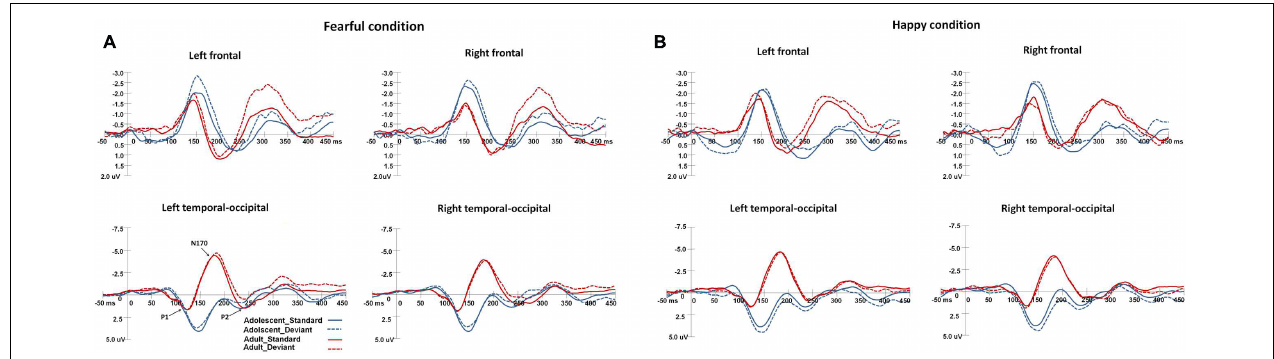
FIGURE 2 | The grand-average ERPs elicited by the standard and deviant stimuli in the happy and fearful oddball conditions for both adolescent and adult groups. ERP responses in the electrodes of F1, FC1, and C1 were averaged to plot the neural activity over the left frontal areas, and F2, FC3, and C2 were averaged for the right frontal areas. The ERP responses in the left occipito-temporal areas were averaged from the electrodes of TP7, P7, PO7, CB1, and O1, and the ERP responses in the electrodes of TP8, P8, PO8, CB2, and O2 were averaged for the right occipito-temporal areas. (A) Shows the ERP waveforms in the fearful condition, and (B) for the ERP waveforms in the happy